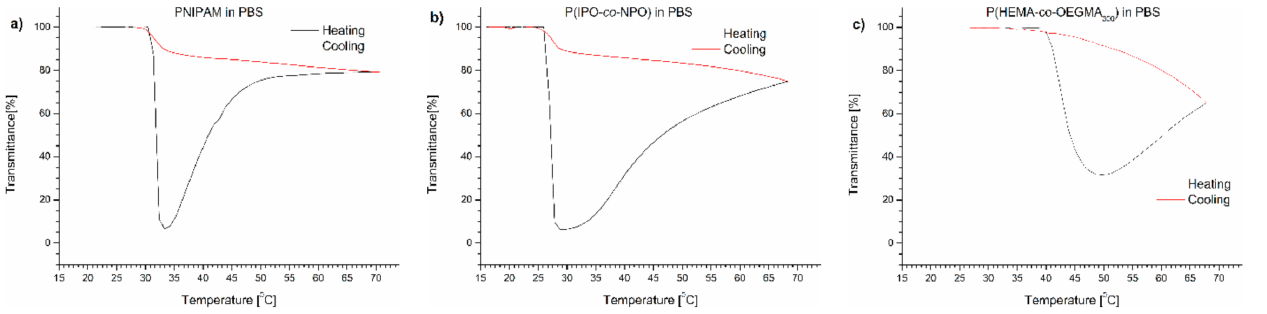
Figure 1. Transmittance versus temperature curves of PBS solutions of ( a ) PNIPAM, ( b ) P(IPO- co -NPO) and ( c ) P(HEMA- co - OEGMA 300 ). Total solute concentration: 0.5 g/L; heating/cooling rate: 1 ◦ C/min. Heating: black; cooling: